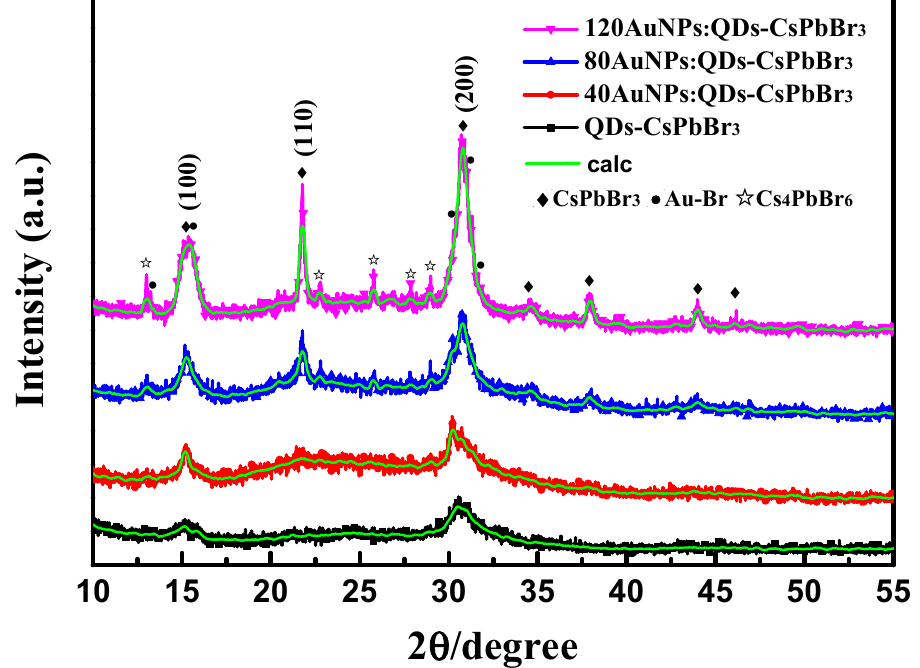
Figure 4. X-ray diffraction (XRD) patterns of annealed QD-CsPbBr 3 , 40AuNPs:QD-CsPbBr 3 , 80AuNPs:QD-CsPbBr 3 and 120AuNPs:QD-CsPbBr 3 films. Figure 5a shows the photoluminescence (PL) spectra of annealed QD-CsPbBr 3 , 40AuNPs:QD-CsPbBr 3 , 80AuNPs:QD-CsPbBr 3 and 120AuNPs:QD-CsPbBr 3 films. It was observed